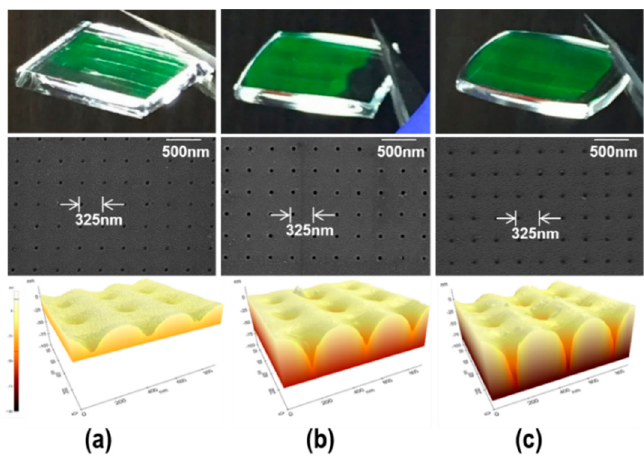
Figure 4. Images (top), top-view SEM images (middle), and 3D surface profiles obtained by AFM measurements (bottom) of glass imprinted samples at the imprinting temperatures of ( a ) 680 °C, ( b ) 690 °C, and ( c ) 700 °C with a fixed pressure of 1 MPa.